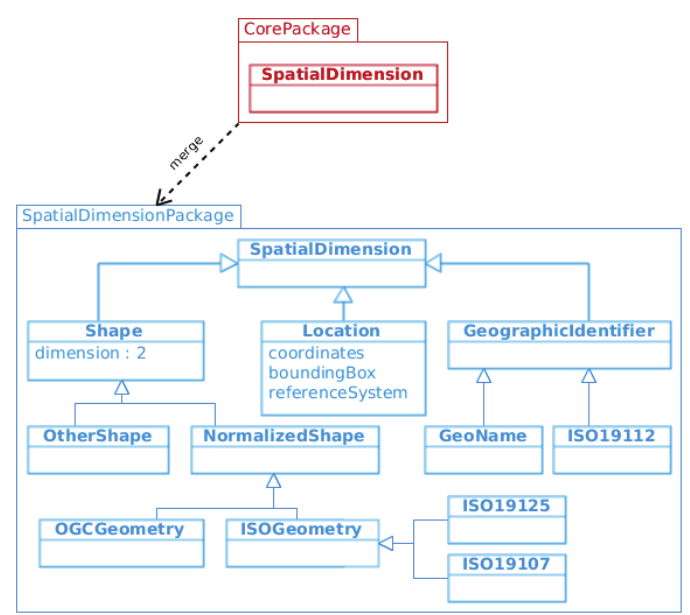
Figure 3: Spatial dimension